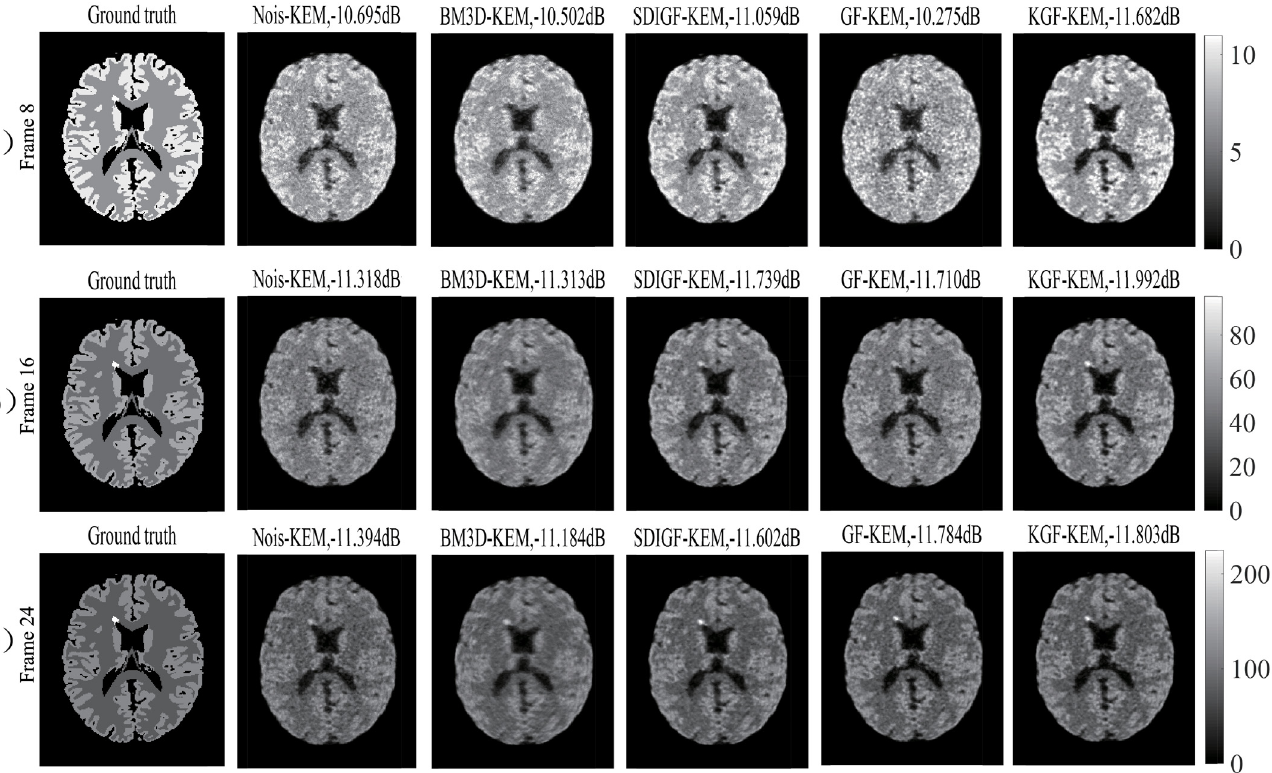
PLOS ONE | https://doi.org/10.1371/journal.pone.0260374 December2,